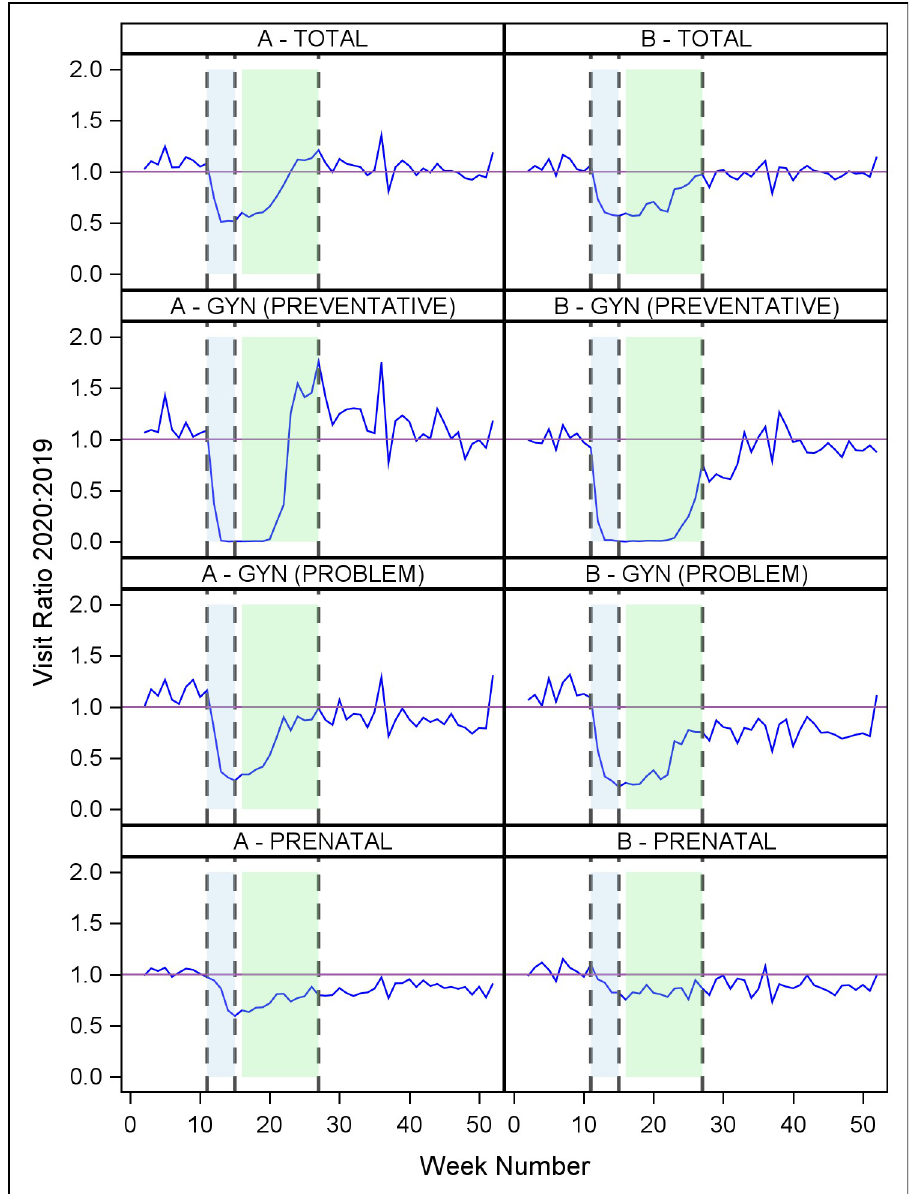
Fig 2. Weekly ratio (2020:2019) of ambulatory visits, by visit type, for each site. A = Allegheny Health; B = Johns Hopkins. The four panels illustrate the trends for all ambulatory visits as well as three visit subtypes: gynecologic (annual) preventative care, gynecologic problem-focused care, and prenatal care. (Vertical reference lines denote periods beginning 3/8/20 (week 11), 4/5/20 (week 15), and 6/28/20 (week 27)). Fig 3 illustrates the proportion of visits conducted as televisits. During 2019 and the pre- pandemic period of 2020, televisits were negligible at both institutions. With the transition to period 2, the mean proportion of televisits rose sharply. By period 3, televisits represented approximately 21% of all visits for both sites, a significant increase ( p < .0001 for both sites). In period 4, televisit use remained higher than prior to the pandemic: the proportion of televi- sits was 6% of all visits for Allegheny Health and 12% of all visits for Johns Hopkins. Televisit